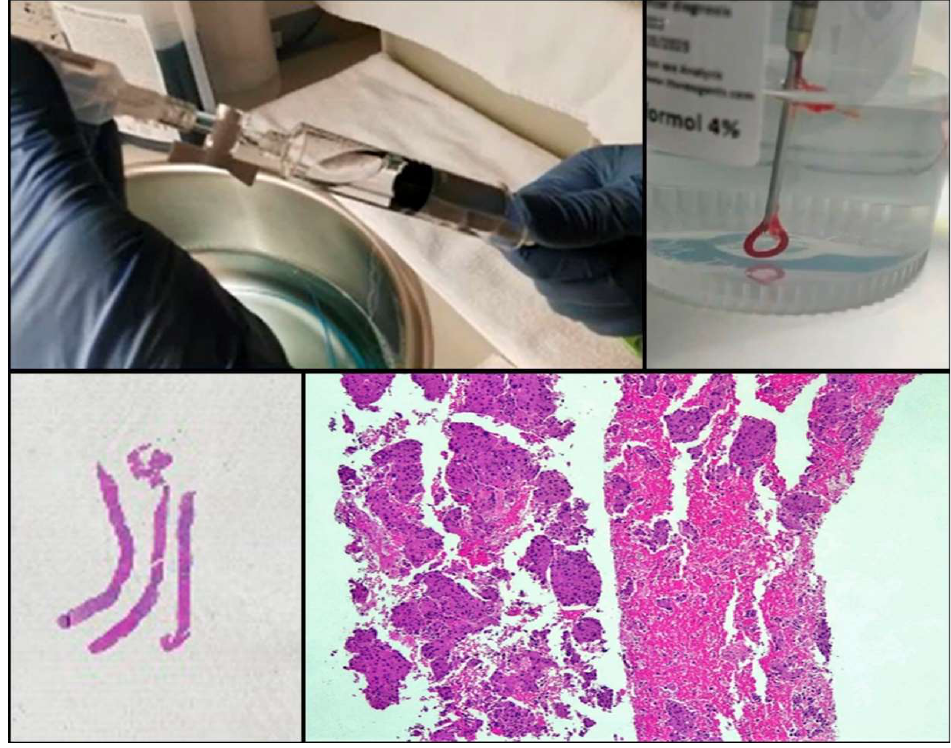
Figure 2. Procurement of cytological samples and small tissue that is directly introduced in formalin.